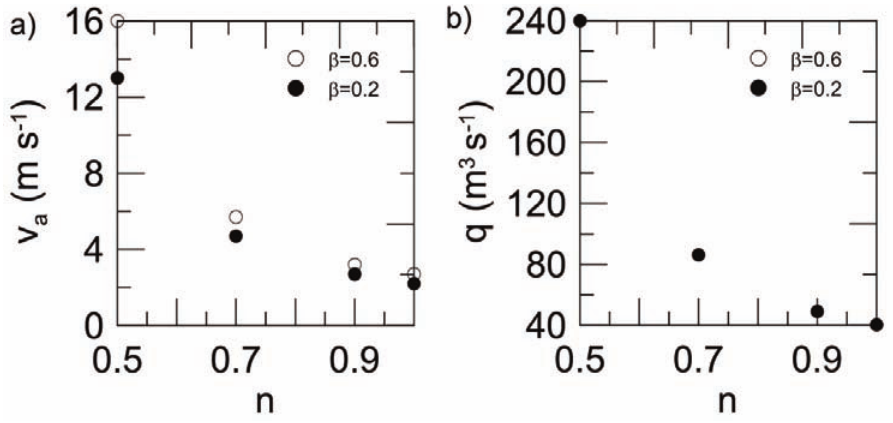
Figure 5 . Pu'u 'O'O (Kilauea, Hawai'i) case study. a) Average velocity v vs n for two values of b . b) Volume flow rate q vs n , with q equal for the two values a of b . The parameters of the channel are: a = 5 m, h = 3 m, a = 10˚; the parameters of the lava are: t = 2600 kg m −3 and k = 895 Pa s n .